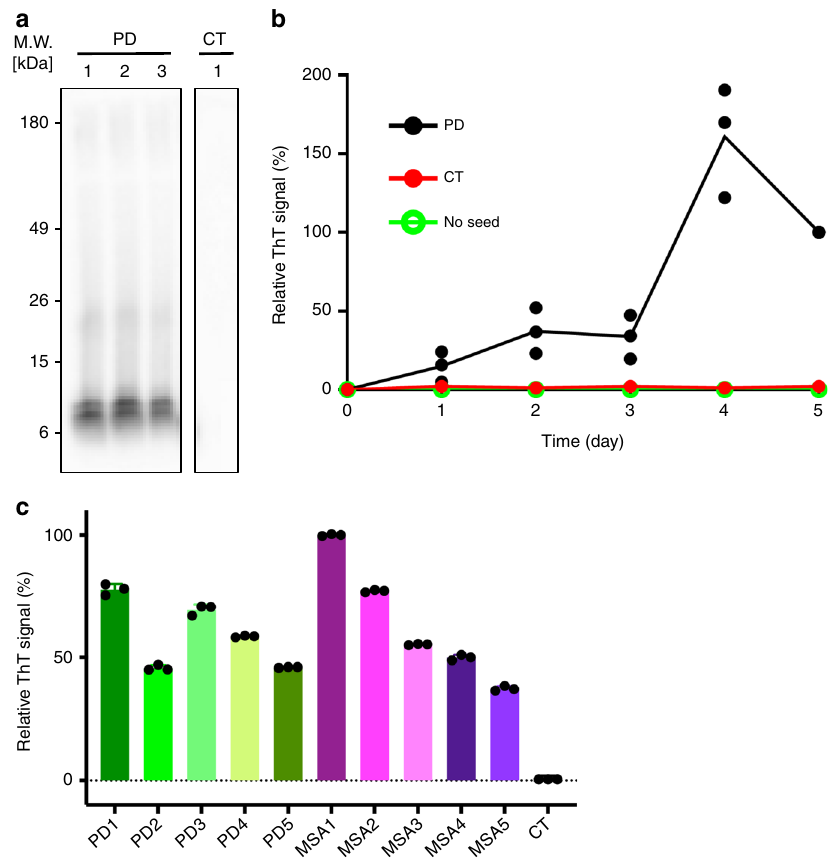
Fig. 1 Ampli fi cation of aSyn aggregates from brain extracts. a Immunoblotting of PMCA products with proteinase-K (PK) digestion. Similar PK-resistant signals were detected in PD samples (PD1-PD3), whereas nothing remained in the control sample (CT; brain extract from an individual, in which an α - synucleinopathy was excluded). An uncropped image of the blot is shown in Supplementary Fig. 1. b ThT-binding kinetics of recombinant aSyn with or without PMCA products as seeds. ThT-intensities for three PD samples (PD1-PD3) were averaged and used to derive error bars. c Relative ThT- fl uorescence after seeding with different PMCA products. Error bars indicate standard deviation over three fl uorescence measurements for each sample.